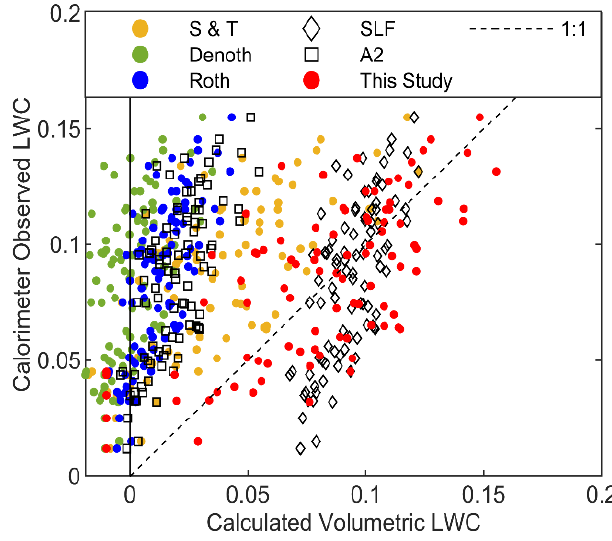
Figure 5. Comparisons of the calorimeter observed liquid water content and the calculated liquid water content based on the observed relative permittivity and density observations for common equations and the regression presented in this study.